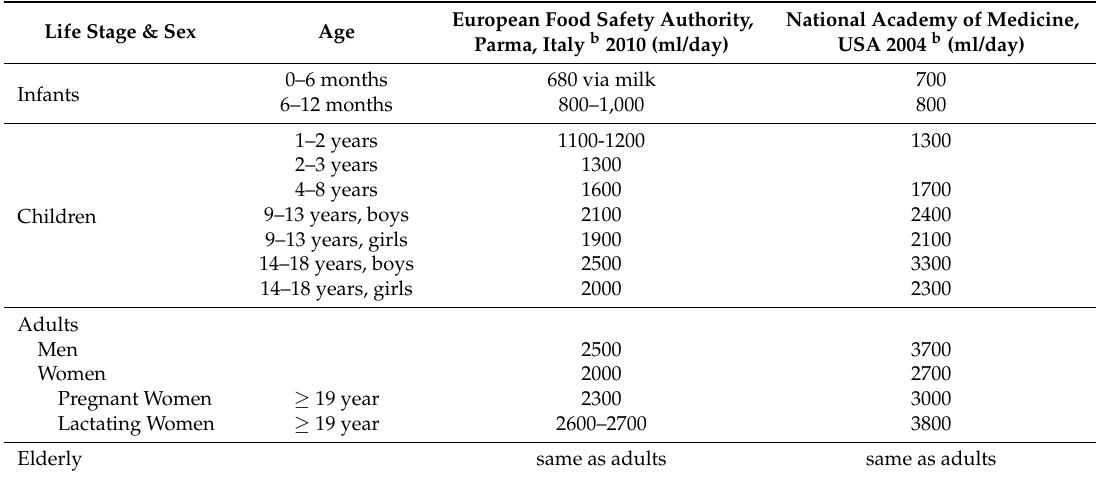
Table 1. Comparison of recommended Adequate Intakes a for water, published by European and American health